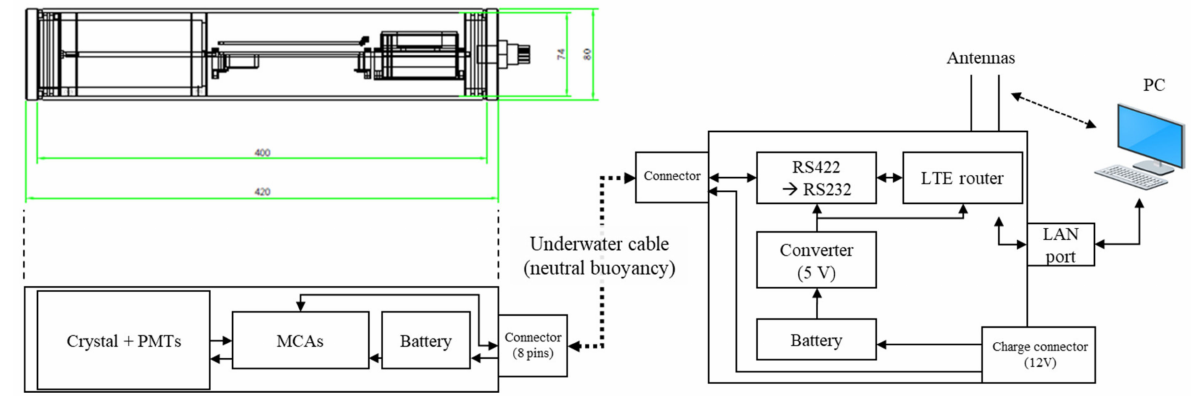
Figure 3. Schematic of the gamma-ray sensor.